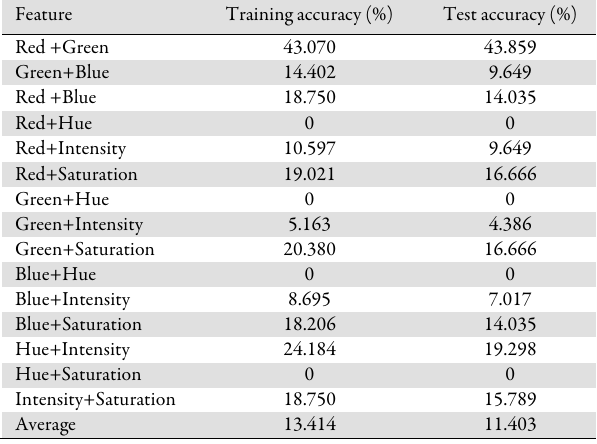
Table 3. Accuracy values using two colour features